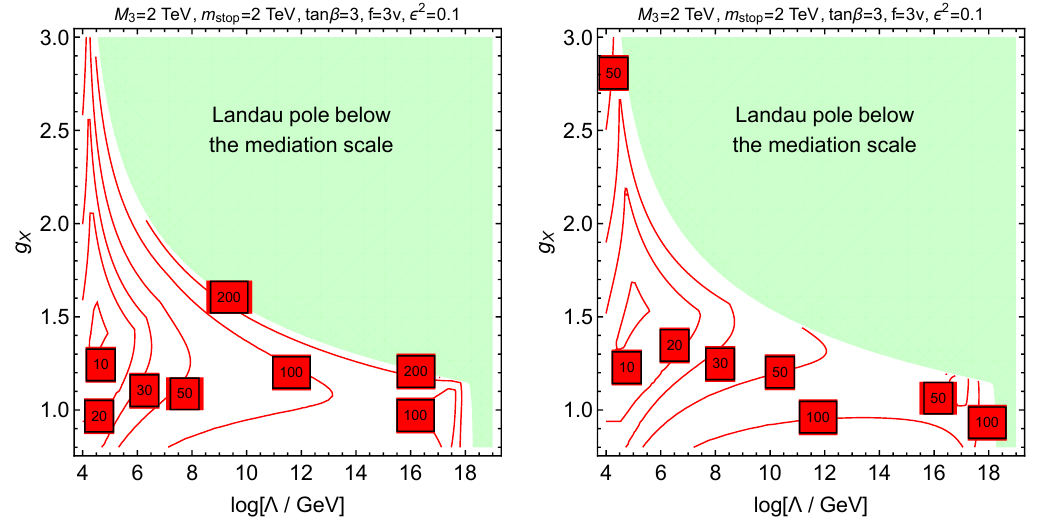
Figure 6 . The same as in the left panel of (cid:12)gure 3 but including the e(cid:11)ect of m 2 assumption that it is constant during the RGE (cid:13)ow (left panel) or assuming that m 2 mediation scale and large value of m 2 RG contribution from the soft mass m 2